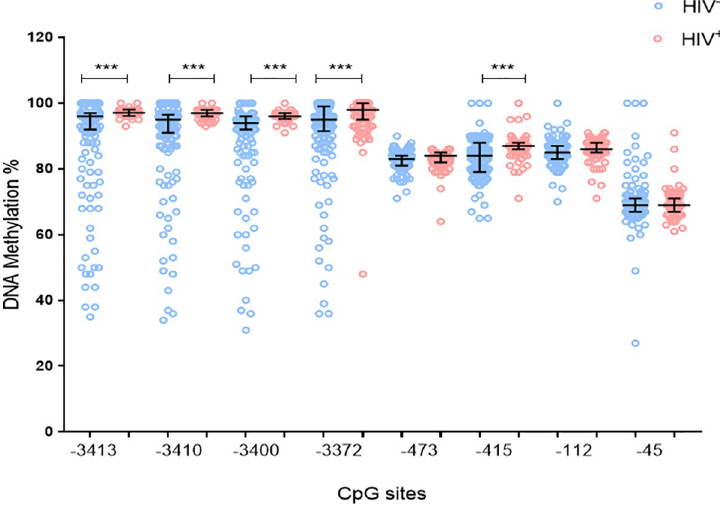
Fig 5. ADIPOQ promoter DNA methylation and HIV status. DNA methylation at eight CpGs within the promoter of ADIPOQ was measured in HIV - (n = 181) and HIV + (n = 105) pregnant women. Data are represented in a scatter dot plot as the median and interquartile range. ��� p <